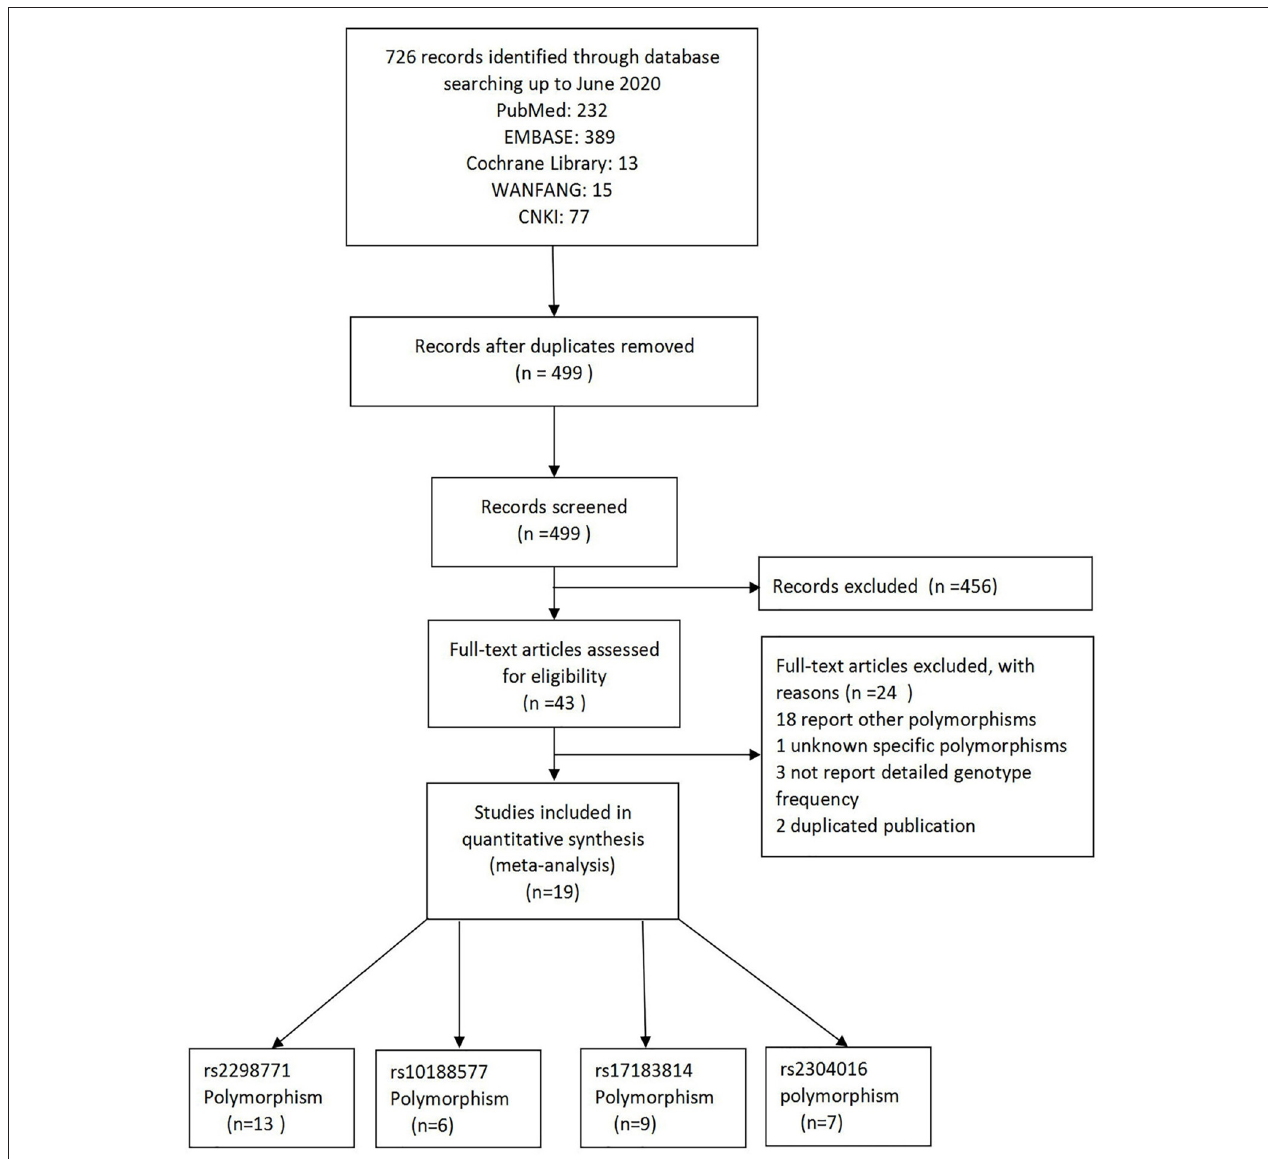
FIGURE 1 | Flow diagram of literature